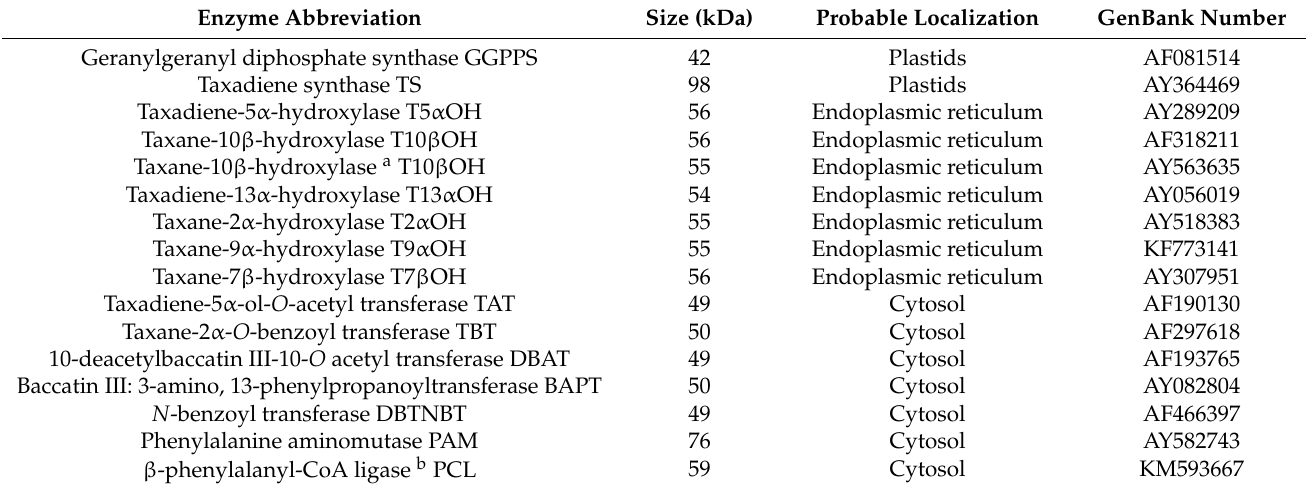
Table 1. Characterized key enzymes in the taxol